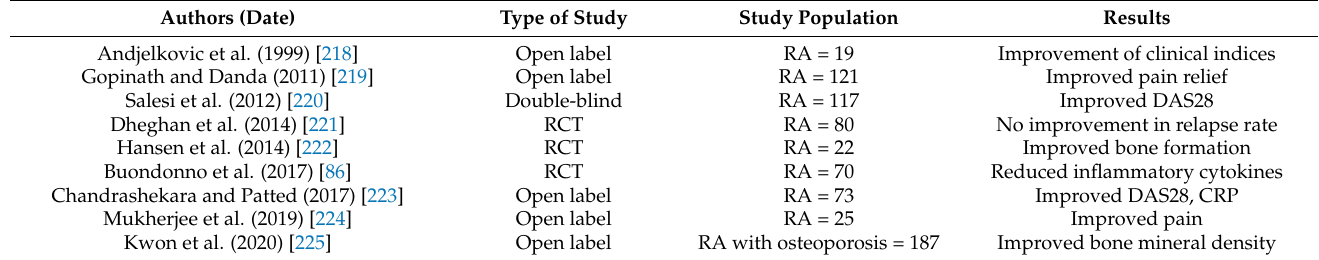
Table 1. Trials in which vitamin D was administered to rheumatoid arthritis (RA) patients, RCT = randomized controlled